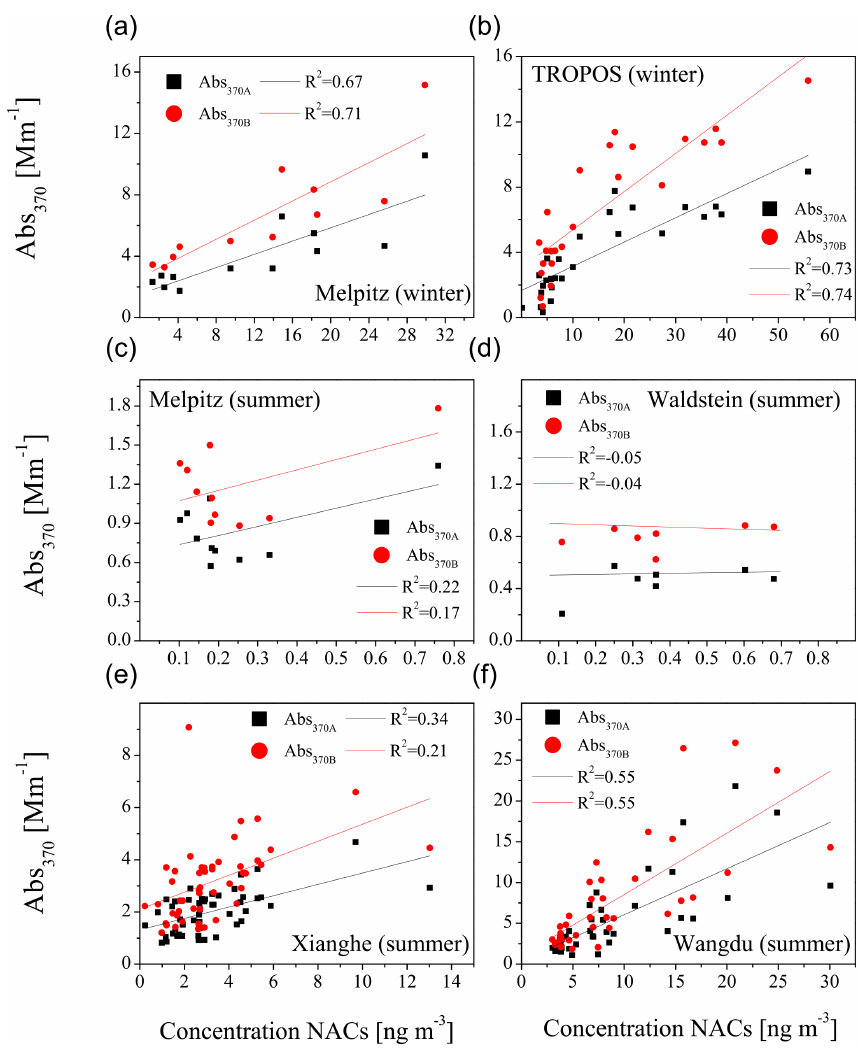
Figure 6. Scatter plots of the sum of NACs concentrations with the aqueous light absorption coefficient (Abs 370 ) for each campaign: (a) Melpitz (winter), (b) TROPOS (winter,), (c) Melpitz (summer), (d) Waldstein (summer), (e) Xianghe (summer) and (f) Wangdu (summer). The aqueous light absorption coefficient is given at 370nm for acidic conditions (indicated by the subscript “A”, black squares) and for alkaline conditions (indicated by the subscript “B”, red